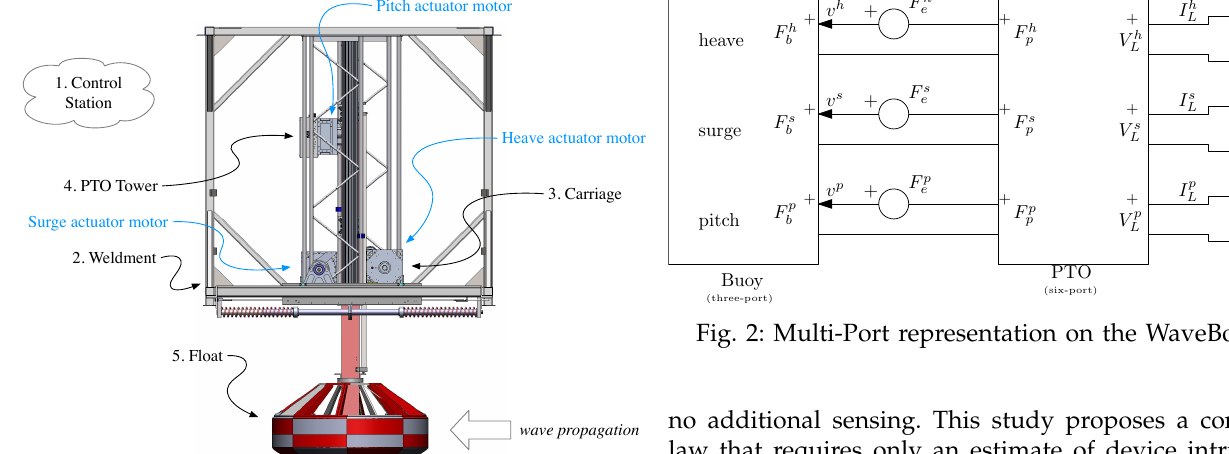
on each DOF connected to a common 300V DC bus.